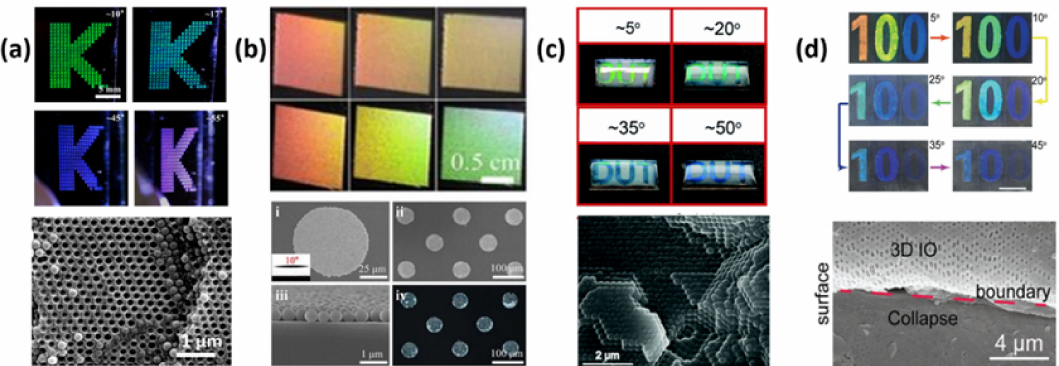
Figure 1. Colloidal photonic crystal (PC) patterns with di ff erent structures based on their angular-dependent structural colors for anti-counterfeiting. ( a ) Anti-counterfeiting colloidal PC (ACPC) patterns with non-close-packed FCC structure. Reused with permission from Reference [20], Copyright 2013, American Chemical Society. ( b ) ACPC patterns composed of mono-layered closest-packed nanoparticles. Reused with permission from Reference [54], Copyright 2016, Springer Nature. ( c ) ACPC patterns with close-packed FCC structures. Reused with permission from Reference [56], Copyright 2018, The Royal Society of Chemistry. ( d ) ACPC patterns with inverse opal structures. Reused with permission from Reference [22], Copyright 2018,